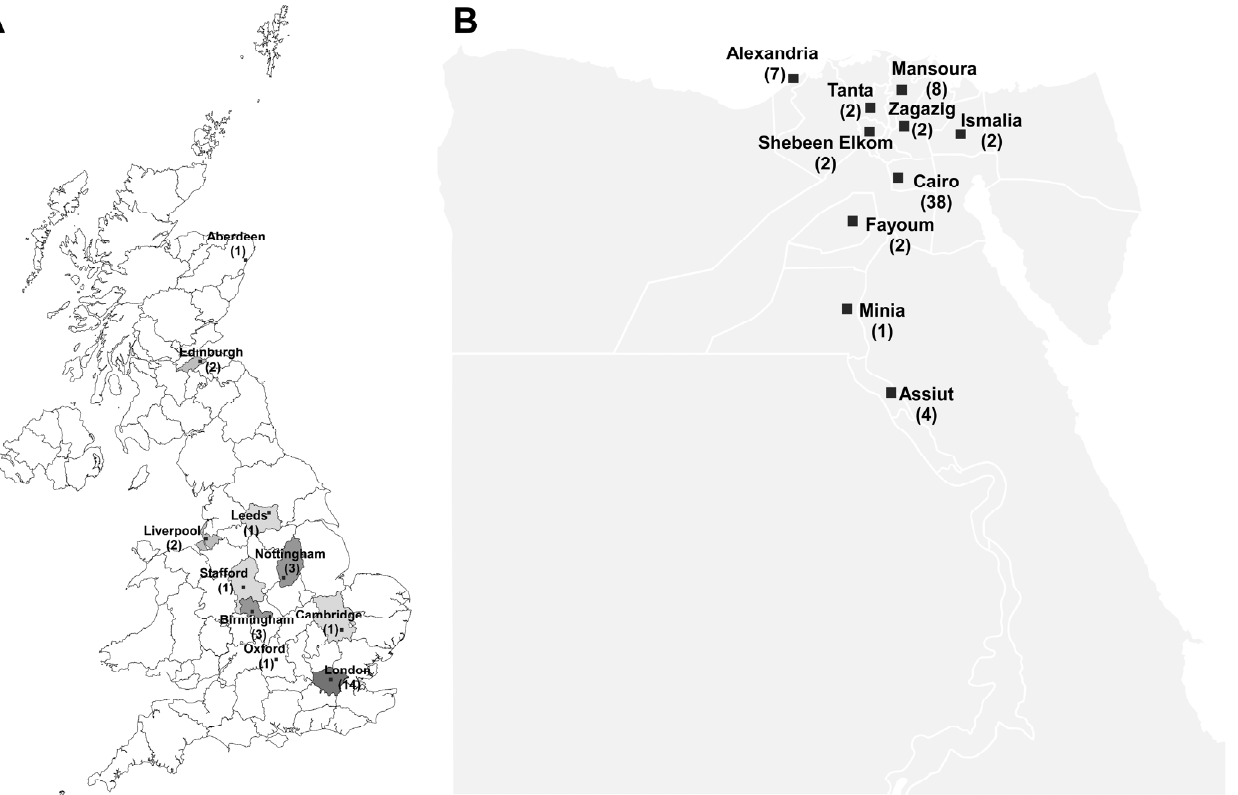
Figure 3. Geographical distribution of the studies in the UK ( A ) and Egypt ( B ). The map of the UK was generated using MapChart (https://www.mapchart.net/uk.html, accessed on 17 December 2022), while the map of Egypt was obtained from the freely available website https://www.slideegg.com/egypt-powerpoint-free (accessed on 30 November 2022). Studies including isolates whose sources were not clearly indicated, those that had more than two localities, and those with origins outside the UK and Egypt were not included in the tally. If a study involved isolates from two localities, it was counted as a study for each of them.